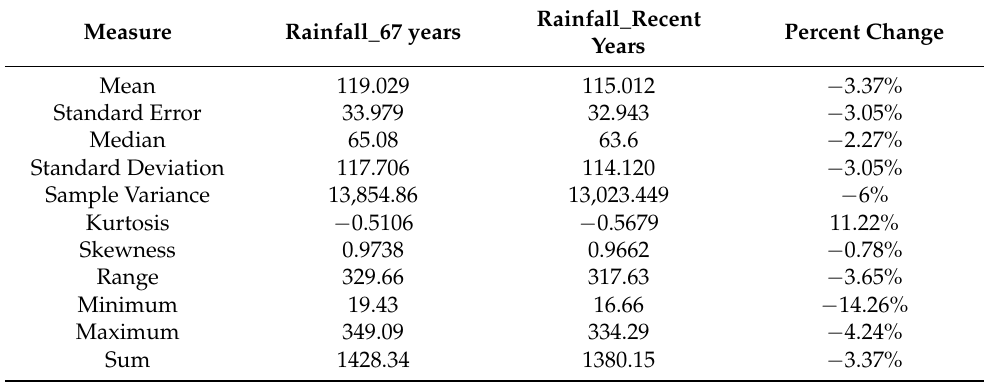
Table 1. Descriptive statistics of monthly rainfall.